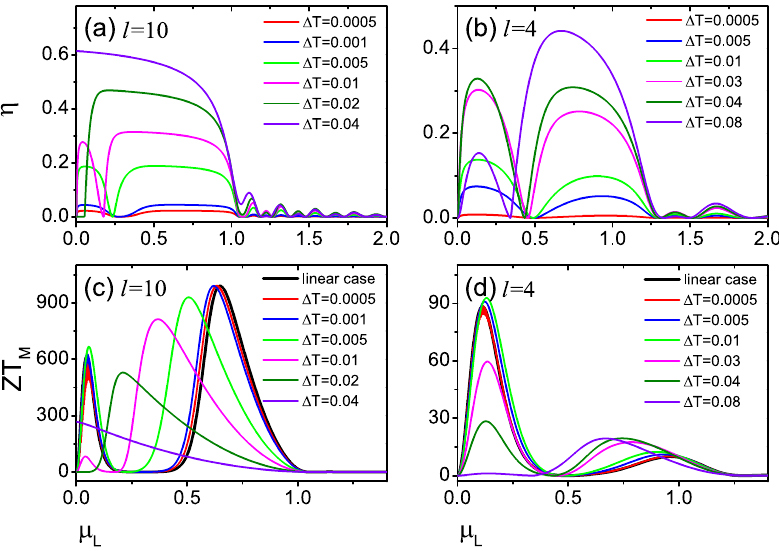
Figure 7. The efficiency η and the equivalent figure of merit ZT M as a function of the chemical potential µ L for different temperature gradient (cid:31) T , with the background temperature T R in ( b,d ). Two magnetic domains of equal size l = 10 with φ black lines in ( c,d ) are ZT in the linear regime. The other unmentioned parameters are the same as in Fig.